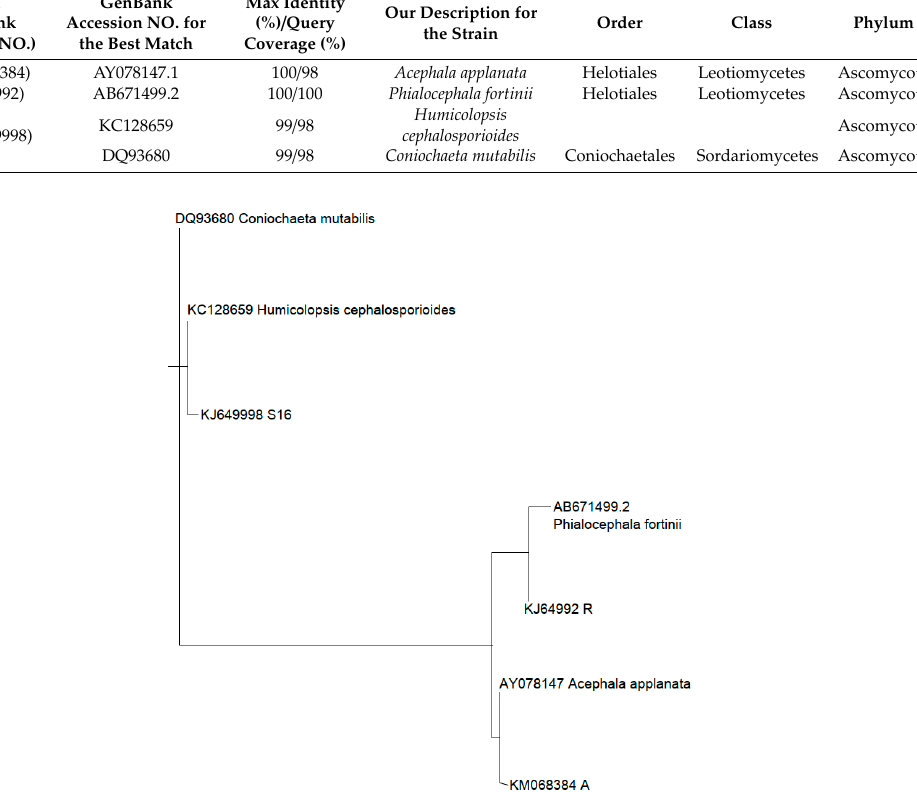
Table 1. The endophytic fungus isolates and NCBI information about the best match and our identification. Strain (GenBank